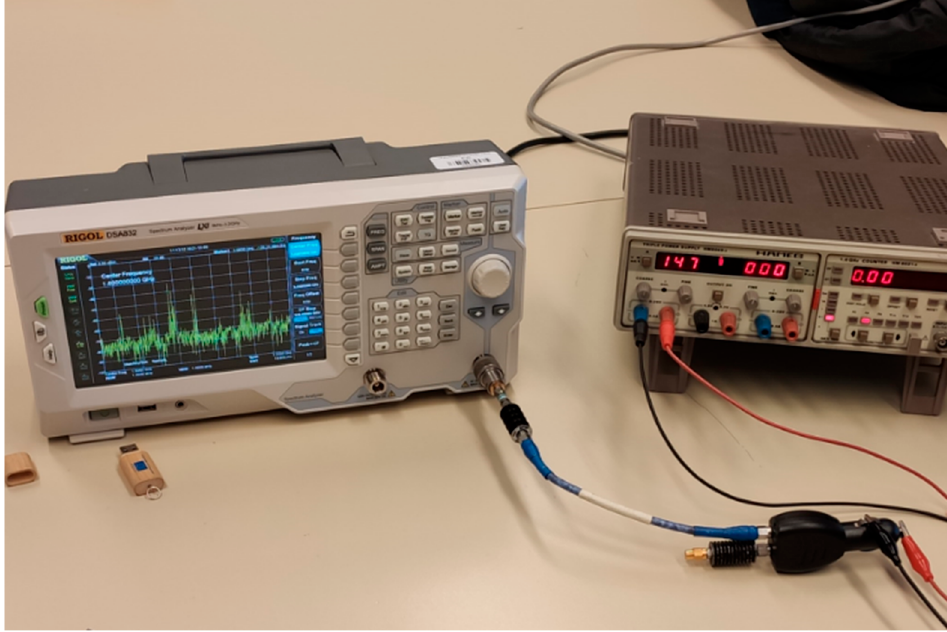
Figure 2. Experimental setup for L1 signal power measurement of jammer 2.